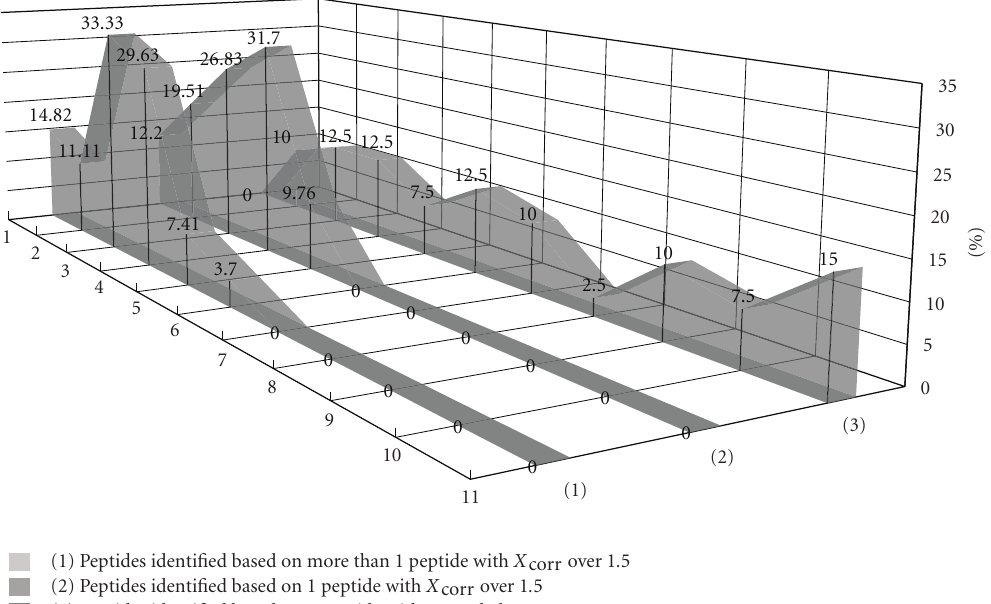
Figure 5: Percentage of the di ff erence between predicted and experimental retention times ( Dt R ) of Bacillus subtilis proteins identified on the basis of one peptide with X corr below 1.5 ( n = 40), over 1.5 ( n = 41), and more than one peptide with X corr over 1.5 ( n =